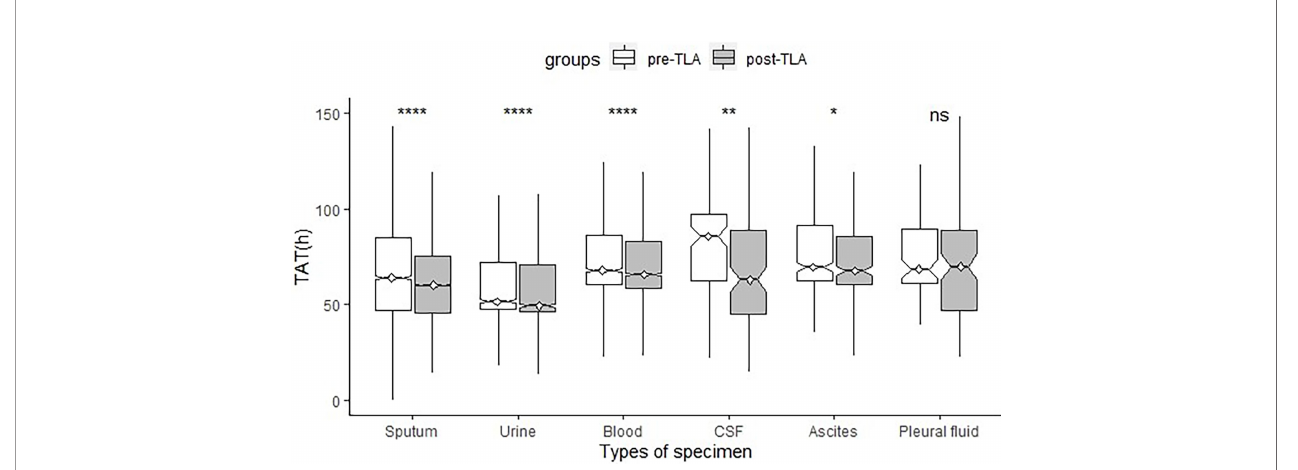
FIGURE 5 | Comparison of TAT of different specimen types between pre-TLA and post-TLA. **** P < 0.0001; ** P < 0.01; * P < 0.1; ns, no signi fi cance; TLA, total laboratory automation; TAT, turnaround time; CSF, cerebrospinal fl uid.